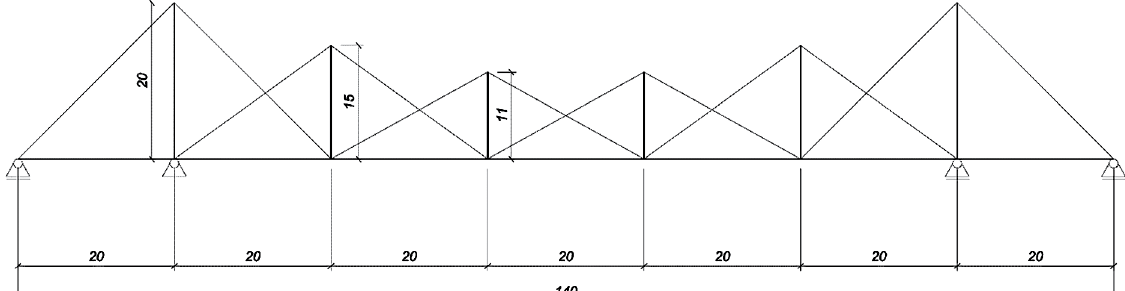
Figure 5. Varying pylons bridge